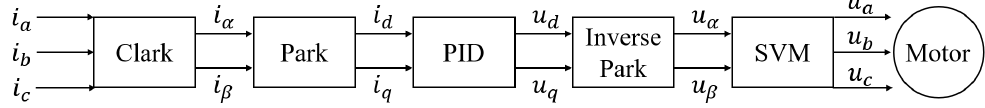
Figure 7. Fundamental steps of field-oriented control